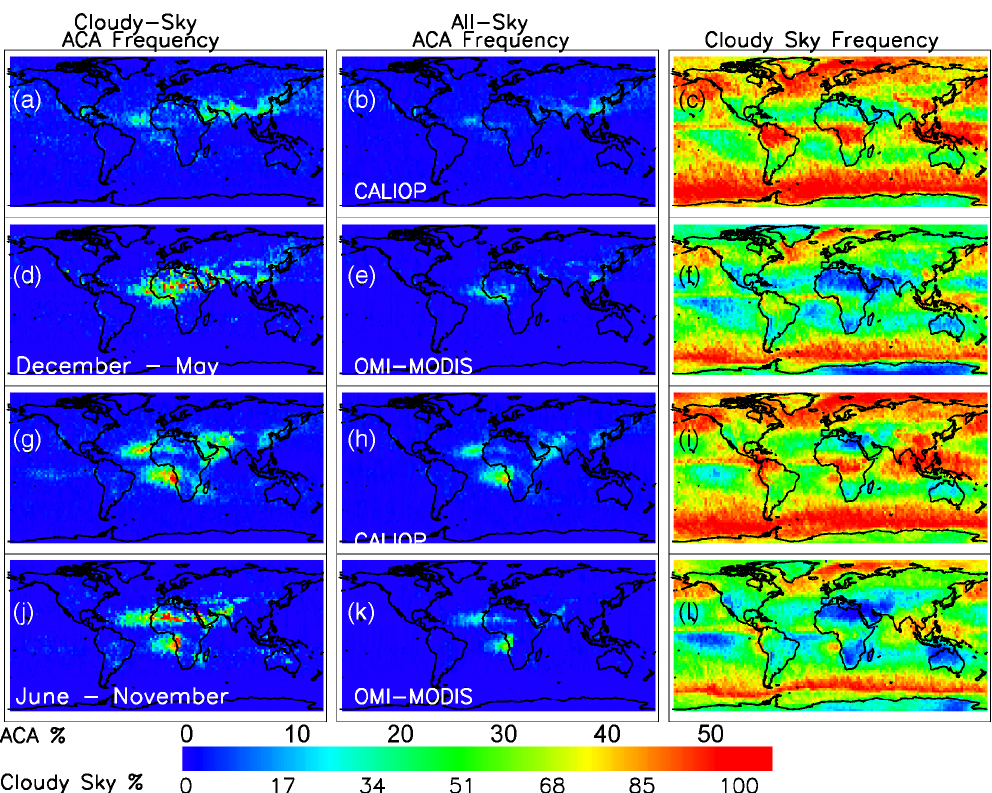
Figure 8. (a) Two-and-a-half-year (June 2006 to November 2008) daytime CALIOP cloudy-sky ACA frequency during the December through May period, using the collocated OMI-MODIS-CALIOP data set (defined in Table 1). (b) The same as (a) but for the all-sky CALIOP ACA frequency. (c) CALIOP cloudy-sky frequency, which is defined as the number of collocated CALIOP observations with COD>0 over the total number of collocated CALIOP observations. (d–f) Similar to (a–c) but using the OMI-MODIS-based method (defined in Table 1). It should be noted that the cloudy-sky frequency from the OMI-MODIS technique is defined as the number of observations with cloud fraction equal to 1 divided by the total number of observations (defined in Table 1). Panels (g–j) depict the same information as (a–f) except for the June–November (2006–2008)